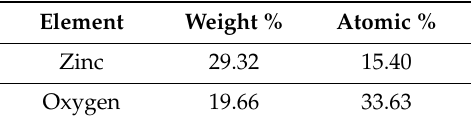
Figure 3. Energy-dispersive X-ray di ff raction spectrum of ZnONPs under study. Table 1. The EDX analysis depicting weight % and atomic % of zinc and oxygen elements present in the as-obtained ZnONPs.